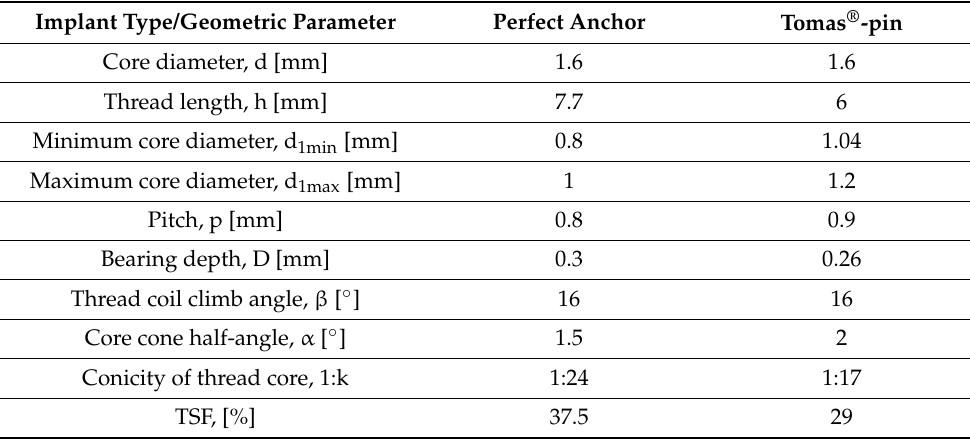
Table 1. Values of geometric parameters established with measuring. Implant Type/Geometric Parameter Perfect Anchor Tomas ® -pin